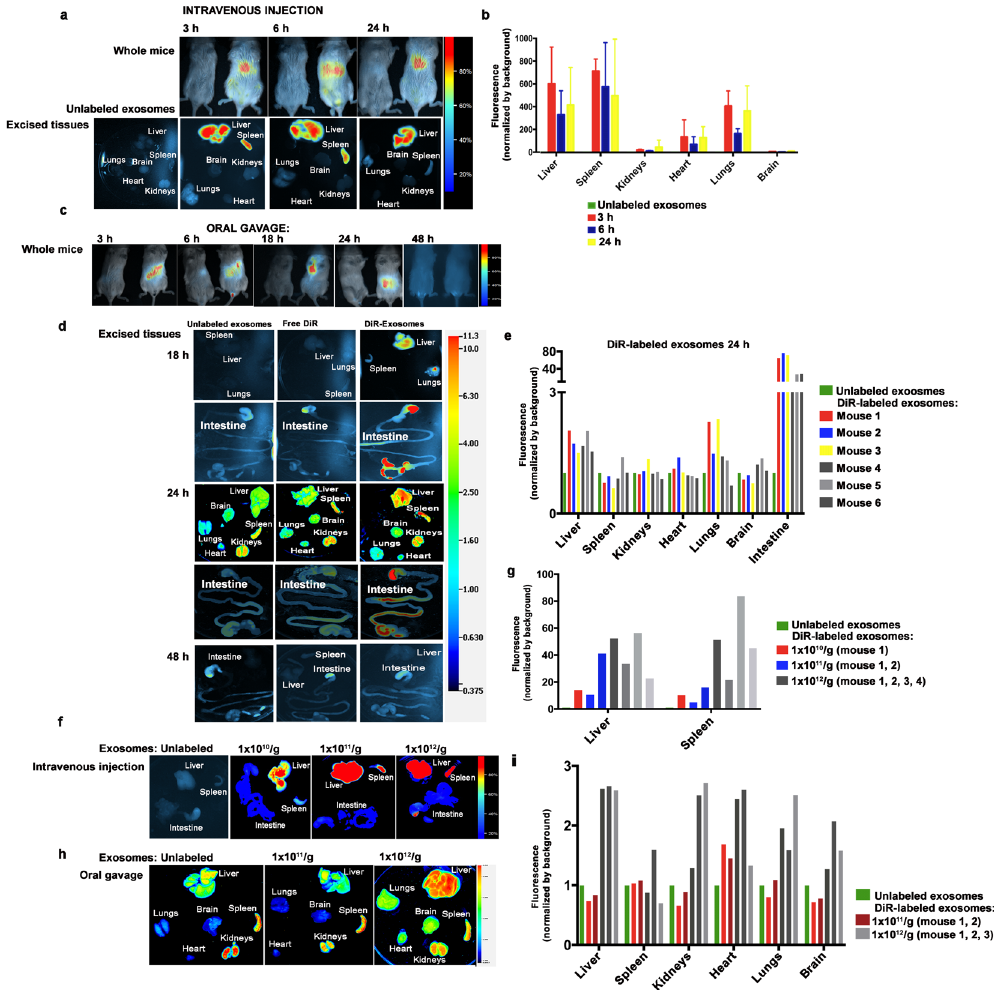
Figure 1. Absorption of bovine milk exosomes in mice. ( a ) DiR-labeled exosomes (1 × 10 12 /g body weight) 3, 6 and 24 hours after intravenous injection in whole Balb/c mice (upper panels) and excised tissues (lower panels). ( b ) Densitometry analysis of fluorescence in excised tissues 3, 6 and 24 hours after intravenous injection of DiR-labeled exosomes. ( c ) Fluorescence in Balb/c mice 3, 6, 18, 24 or 48 hours after oral gavage of DiR- labeled (right mouse) or unlabeled exosomes (left mouse; 1 × 10 12 /g body weight). ( d ) Fluorescence in excised organs of Balb/c mice 3, 6, 18, 24 or 48 hours after oral gavage of free DiR, unlabeled or DiR-labeled exosomes (1 × 10 12 /g body weight). ( e ) Densitometry analysis of fluorescence in excised tissues after oral gavage of unlabeled or DiR-labeled exosomes at 24 hours, normalized for plate background for each mouse analyzed. ( f ) Dose-response analysis of fluorescence in excised murine tissues 24 h after intravenous injection with unlabeled or DiR-labeled exosomes (1 × 10 10 /g, 1 × 10 11 /g, 1 × 10 12 /g body weight). ( g ) Densitometry analysis of excised tissues after intravenous injection of unlabeled or DiR-labeled exosomes for each mouse analyzed (1 × 10 10 /g, 1 × 10 11 /g, 1 × 10 12 /g body weight). ( h ) Dose-response analysis of fluorescence in excised murine tissues 24 h after oral gavage with unlabeled or DiR-labeled exosomes (1 × 10 11 /g, 1 × 10 12 /g body weight) 24 h after oral gavage. ( i ) Densitometry analysis of excised tissues after oral gavage of unlabeled or DiR-labeled exosomes in dose-response experiments. Panels in this figure were assembled from multiple independent images and gels; individual images in the grouped figure are separated by white